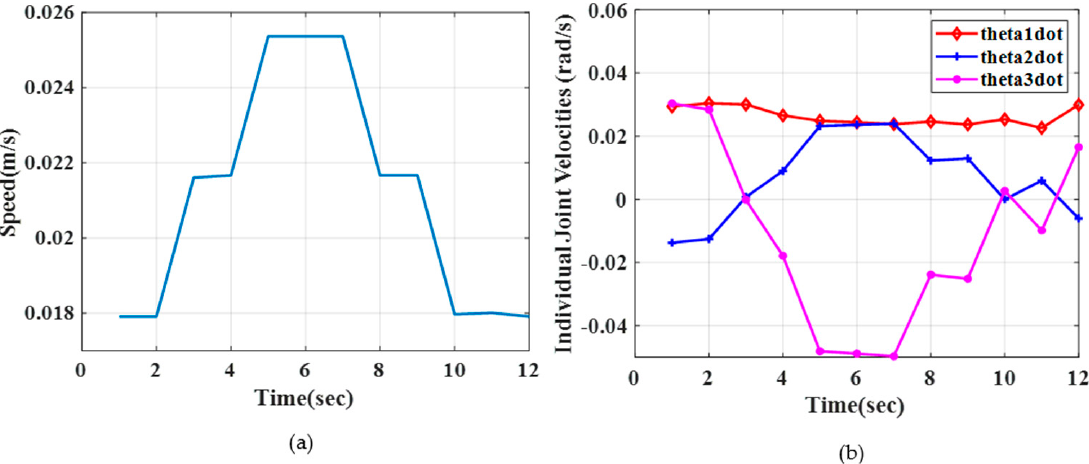
Figure 17. ( a ) Real-time Path Speed Profile of the Robot with Two Obstacles using Double DQN ( b ) Real-time Joint Velocities of the Robot with Two Obstacles using Double DQN.